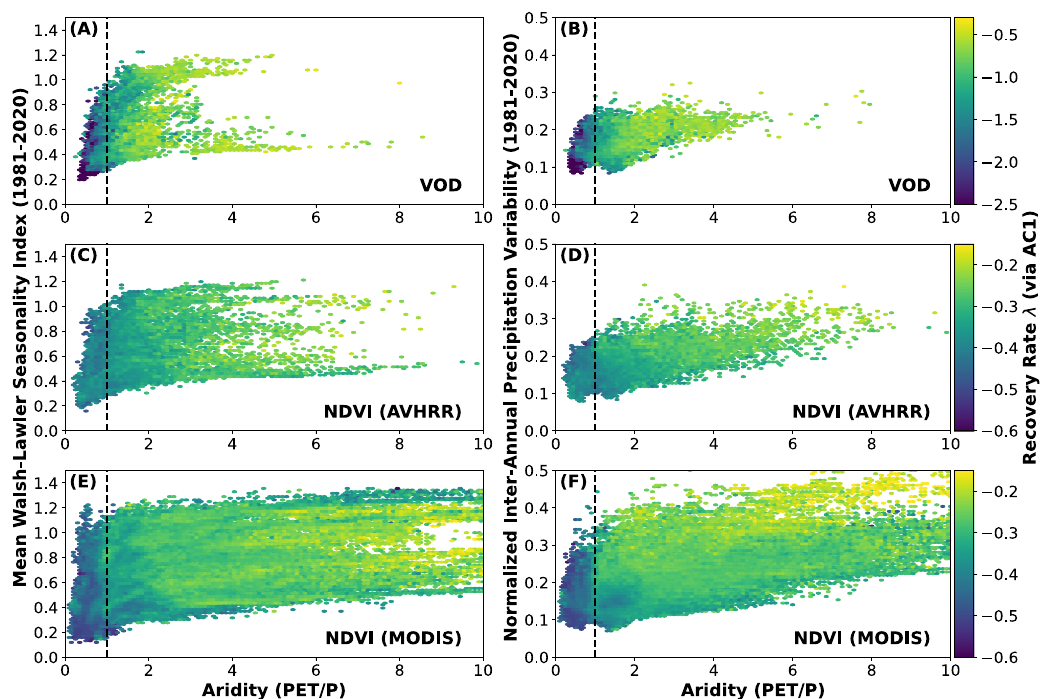
Fig. 2 | Comparison of aridity and intra- and inter-annual precipitation varia- bility in their relative importance for vegetation resilience at the global scale. A , B Vegetation optical depth (VOD), C , D GIMMS3g normalized difference vege- tation index (NDVI), and E , F MODIS NDVI. Aridity compared to intra-annual (left column) and inter-annual (right column) precipitation variability. Hexbins colored by recovery rate computed from AC1 (minimum fi ve points per bin). Values of the